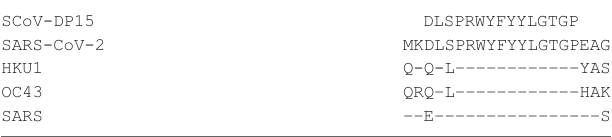
Shown are homologous amino acid sequences within the nucleocapsids of the coronaviruses SARS-CoV-2, HKU1, OC43 and SARS. SCoV-DP15: 15 amino acid long peptide used for peptide stimulation